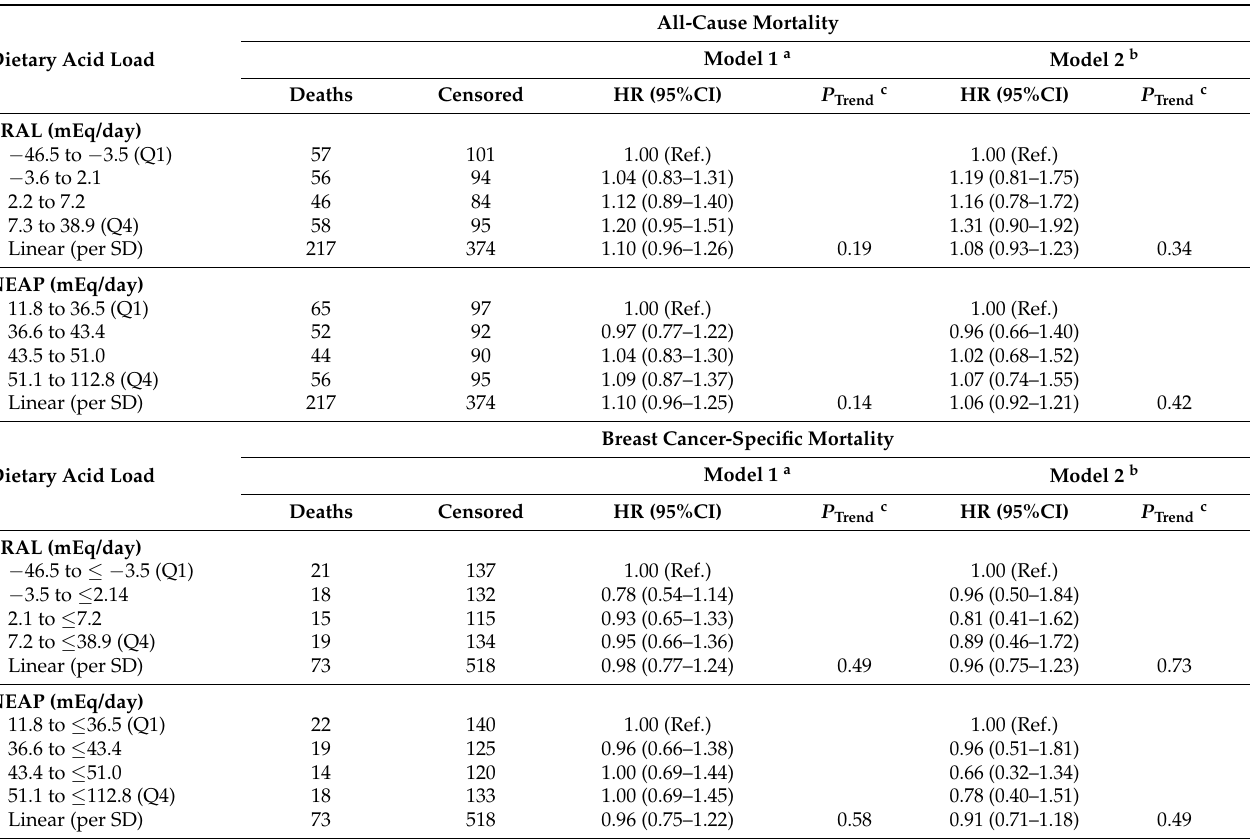
Table 2. Hazard ratios (HRs) and 95% confidence intervals (CIs) for the associations between dietary acid load and all-cause and breast cancer-specific mortality in the Long Island Breast Cancer Study Project ( n = 591).